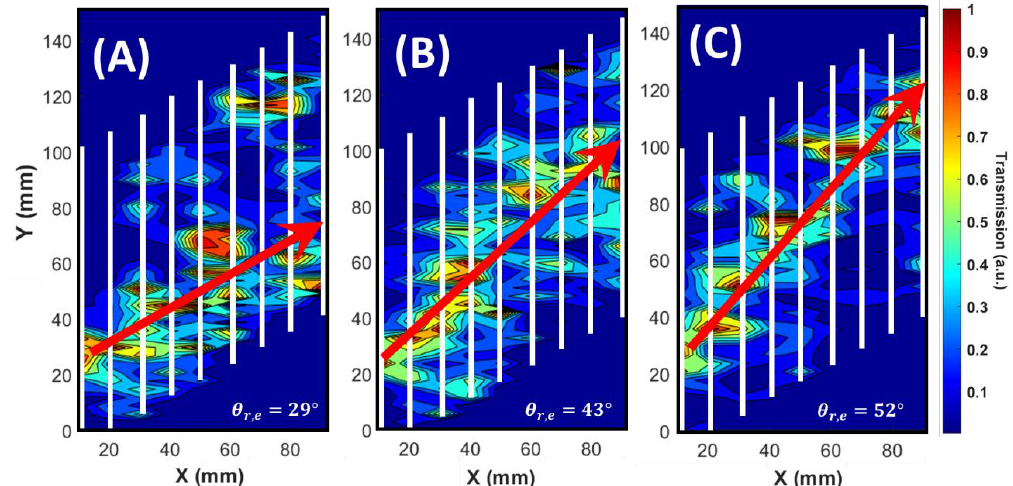
Figure 3. Experimental results of broadband pulse sourced sound intensity maps between the superlattice layers with 10° incidence to the structure. The subfigures illustrate the single frequency dependent refraction angles inside the superlattice obtained from Fourier transformation of the recorded time domain data. The acoustic intensity distribution maps are shown in normalized linear scale. ( A ) 95 kHz. ( B ) 105 kHz. ( C ) 115 kHz. θ r refers to refraction angle. Subindex e indicates experimental